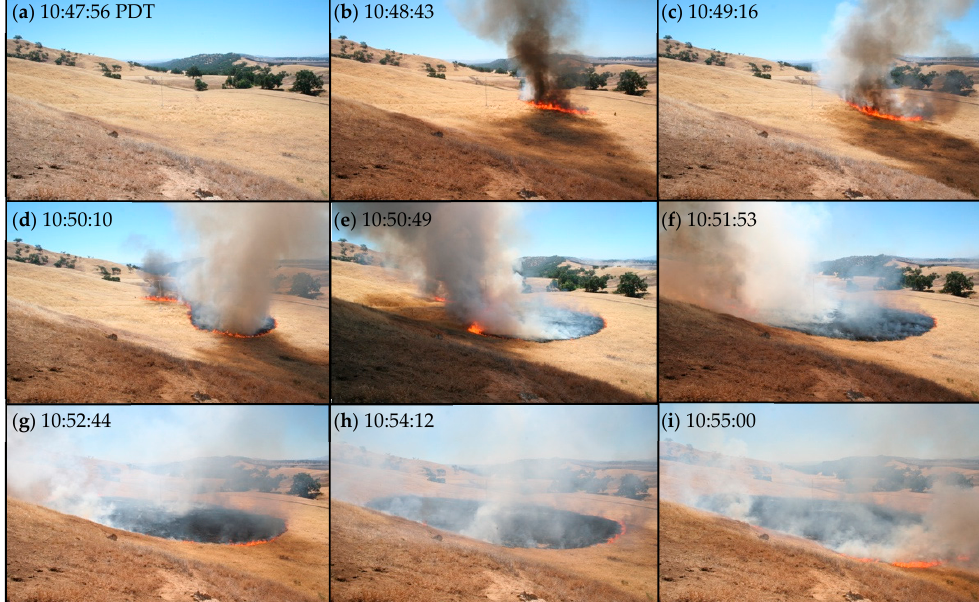
Figure 8. ( a – i ) Photographic time series showing fire front positions and plume structures, taken from a remote camera located in the burn unit (see Figure 2a). Times indicted are HH:MM:SS (PDT). Please refer to Figure 1 for plot orientation. Camera was located at location c in Figure 1.